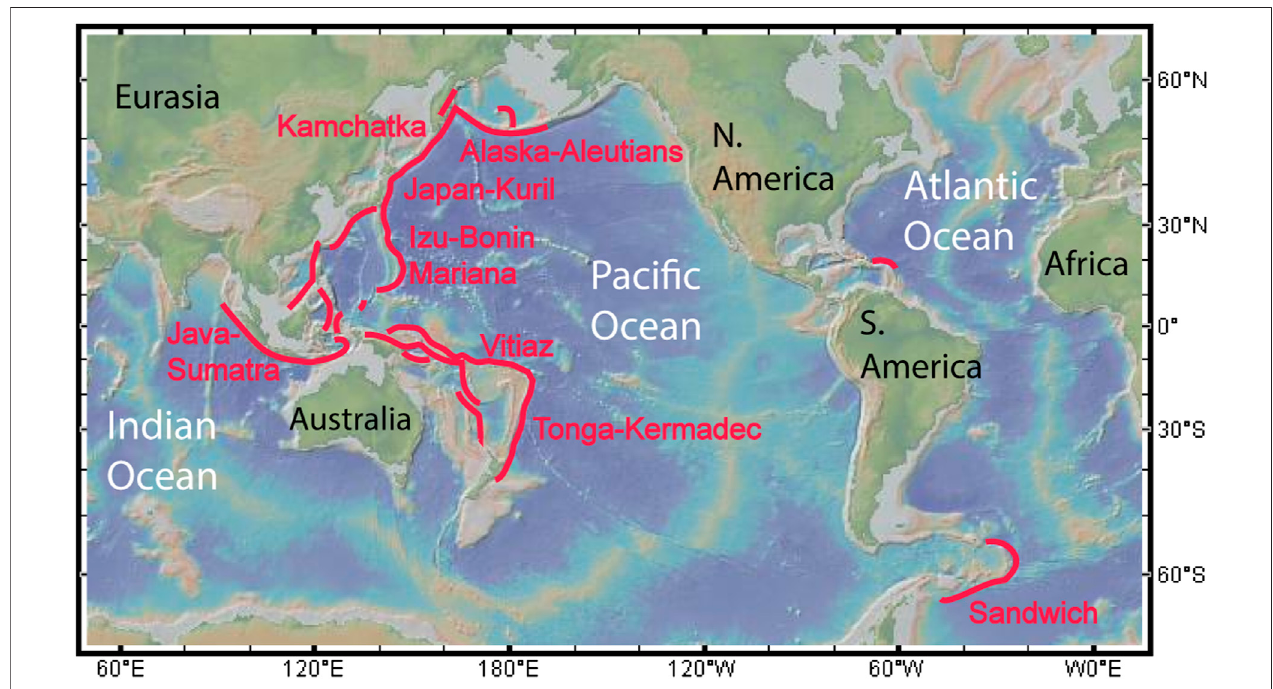
FIGURE 11 | Global map showing the self-sustained intra-oceanic subduction zones during the Cenozoic epoch. 24oceanic subduction zones (in red) have been proposed to have reached the self-sustained state since the Cenozoic, which corresponds to ~39,360 km cumulative trench length (Lallemand and Arcay, 2021). The world map was made with GeoMapApp